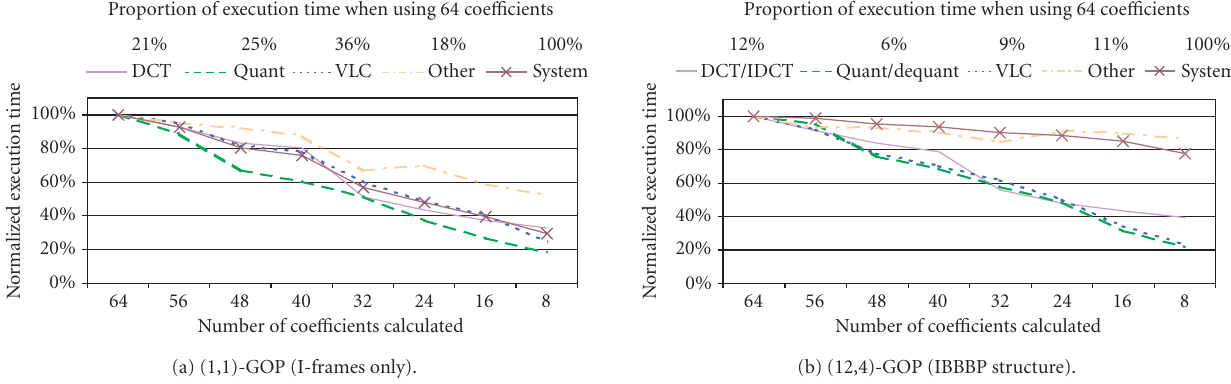
Figure 13: Complexity reduction of the encoder modules relative to the full DCT processing, with (1,1)-GOPs (a) and with (12,4)-GOPs) (b). Note that in this case, 62% of the coding time is spent in (b) for ME and MC (not shown for convenience). For visualization of the complexity reduction, we normalize the execution time for each module to 100% for full processing.